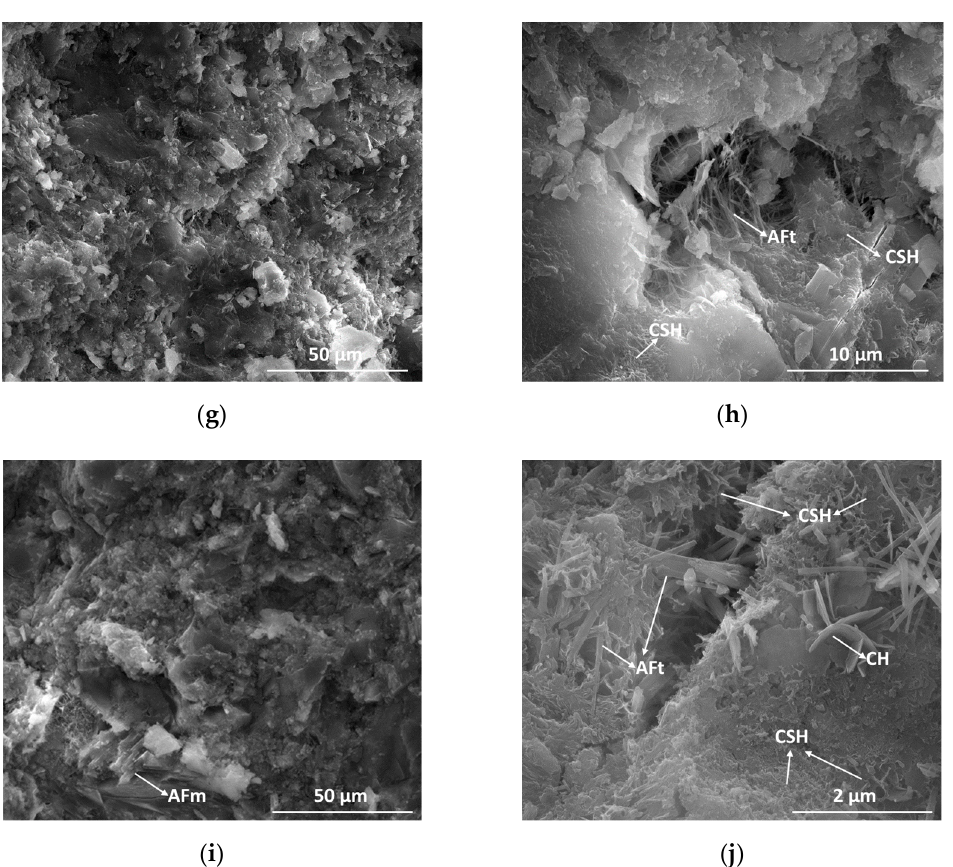
Figure 8. SEM images of hardened mortars at 28 days: E ( a , b ), L3 ( c , d ), L15 ( e , f ), CC0.5 ( g , h ) and CC7.4 ( i , j ).